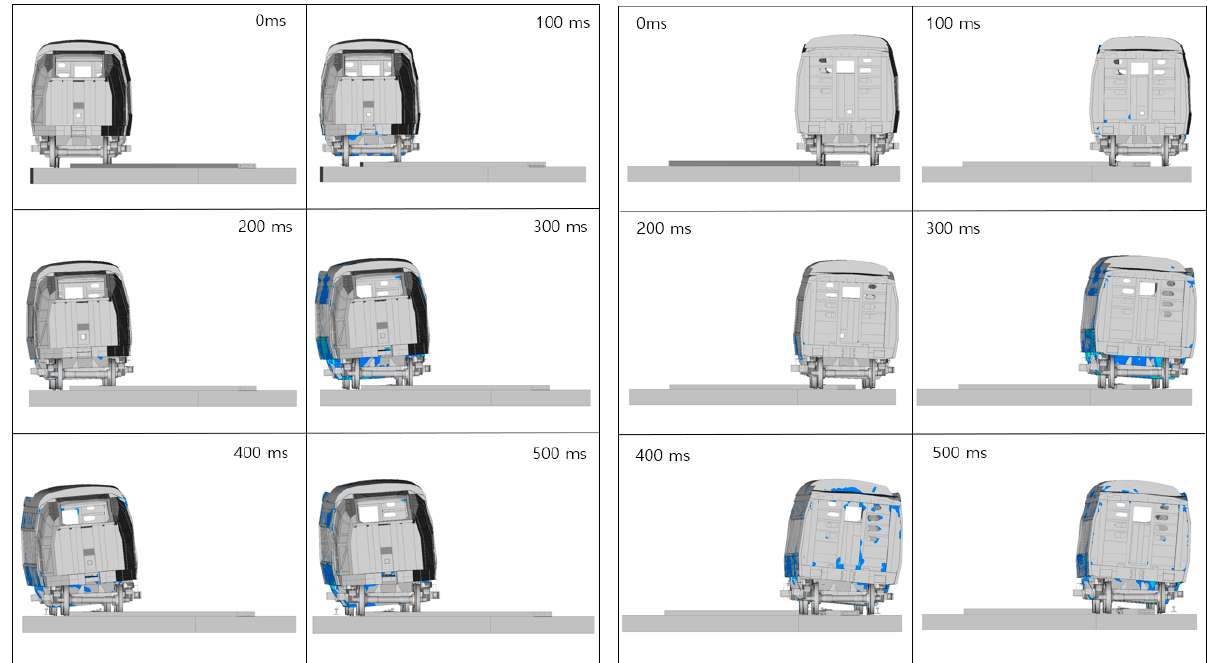
Figure 14. Collision behaviors of the vehicle (front and rear views) [R3500, 300 km/h]. In Figure 15, the collision behaviors observed from the top-down view are shown, and damage to the DCP is visible after the vehicle impact. The concrete surface was damaged due to the impact force of the wheels, as shown in Figure 16. However, an essential aspect of the derailment simulations is to determine the load applied to the DCP. Therefore, the simulation results were analyzed to determine the impact forces transmitted to the DCP during the collision.